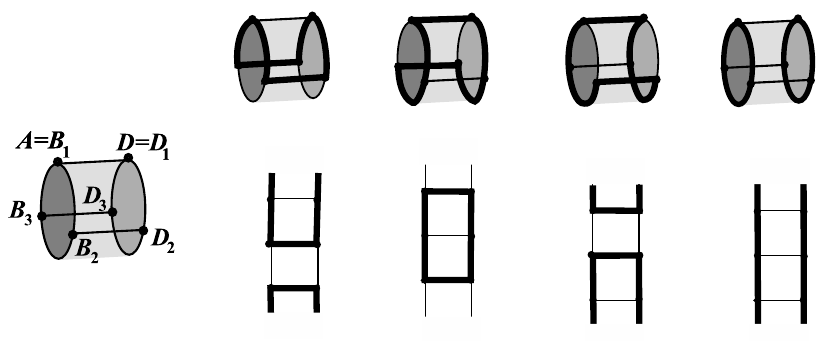
Figure 3. The graph TnC 3 ( 2 ) = C 3 × P 2 with all the possible 2-factors (bold edges) and their flat representations